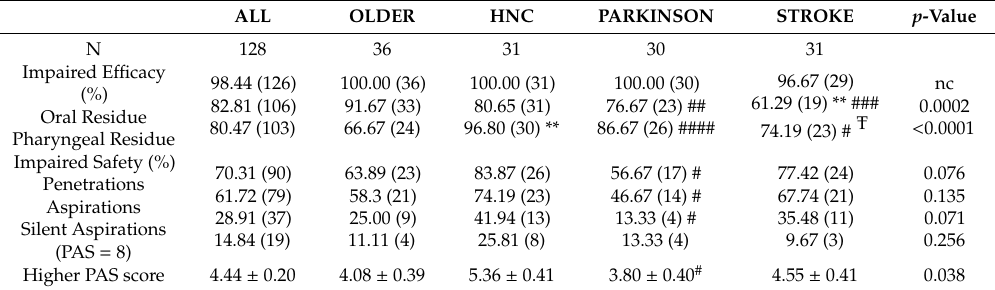
Table 2. Videofluroscopic signs of impaired e ffi cacy and safety of swallow in the study groups (continuous variables expressed as mean ± SEM) for any viscosity level.